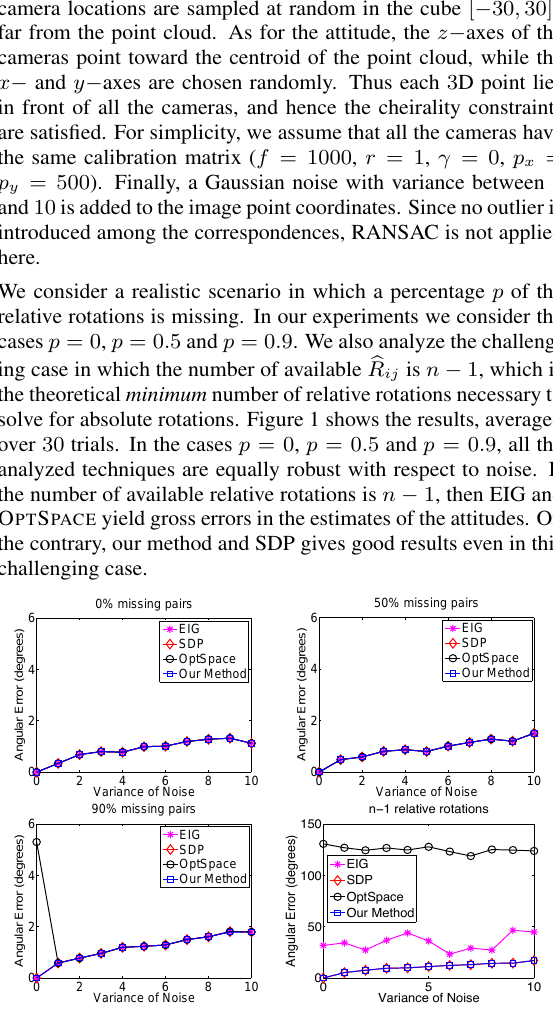
Figure 1: Mean angular errors in estimating the absolute rotations as a function of the variance of Gaussian noise. Note that in the bottom right figure the scale in the y − axis is different from the other figures.